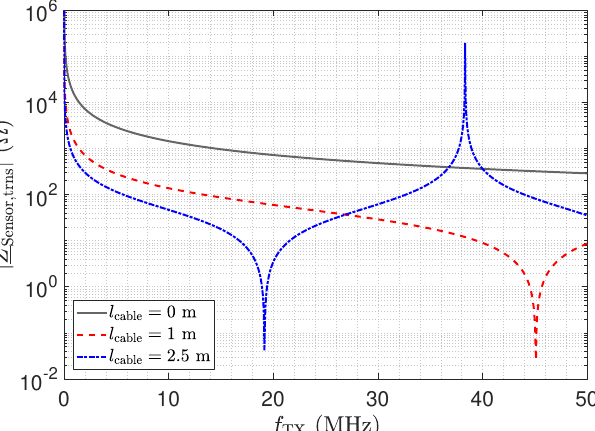
Figure 12. Analytical result of the transformed sensor impedance Z Sensor,trns , as depicted in Figure 10. The result for a length of 0m corresponds to Z Sensor . Close to 40MHz, where the blue trend and the red trend meet, a λ /2 setup is